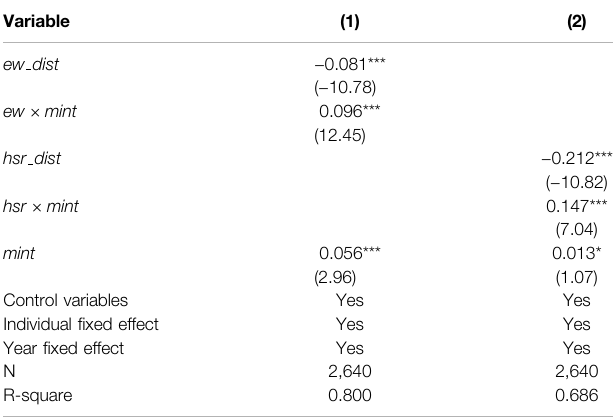
TABLE 8 | Second-stage regression results of instrumental